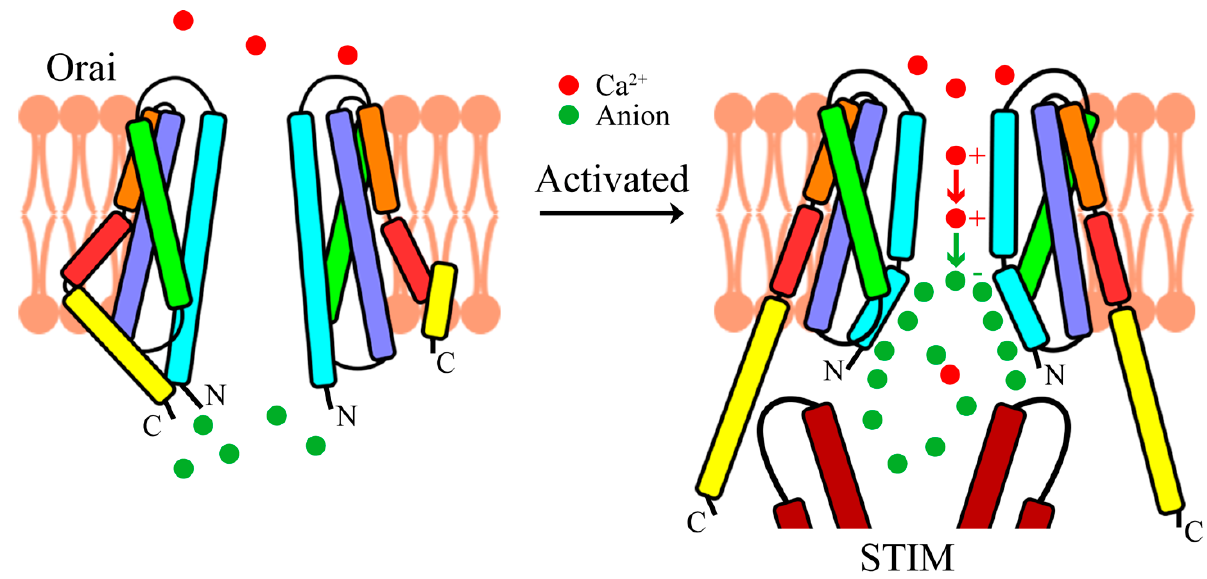
Figure 4. Proposed “push–pull model” of Ca 2+ permeation. After STIM binds to the Orai channel, conformational changes in the Orai channel transduce along the pathway from the outermost TM4 helix to the innermost TM1 helix, inducing dilation at the cytosolic end of the TM1 helix. The Ca 2+ ions inside the pore are pushed (denoted by the red arrow) by extracellular Ca 2+ and pulled (denoted by the green arrow) by intracellular anions, thus passing through the pore of the Orai channel.